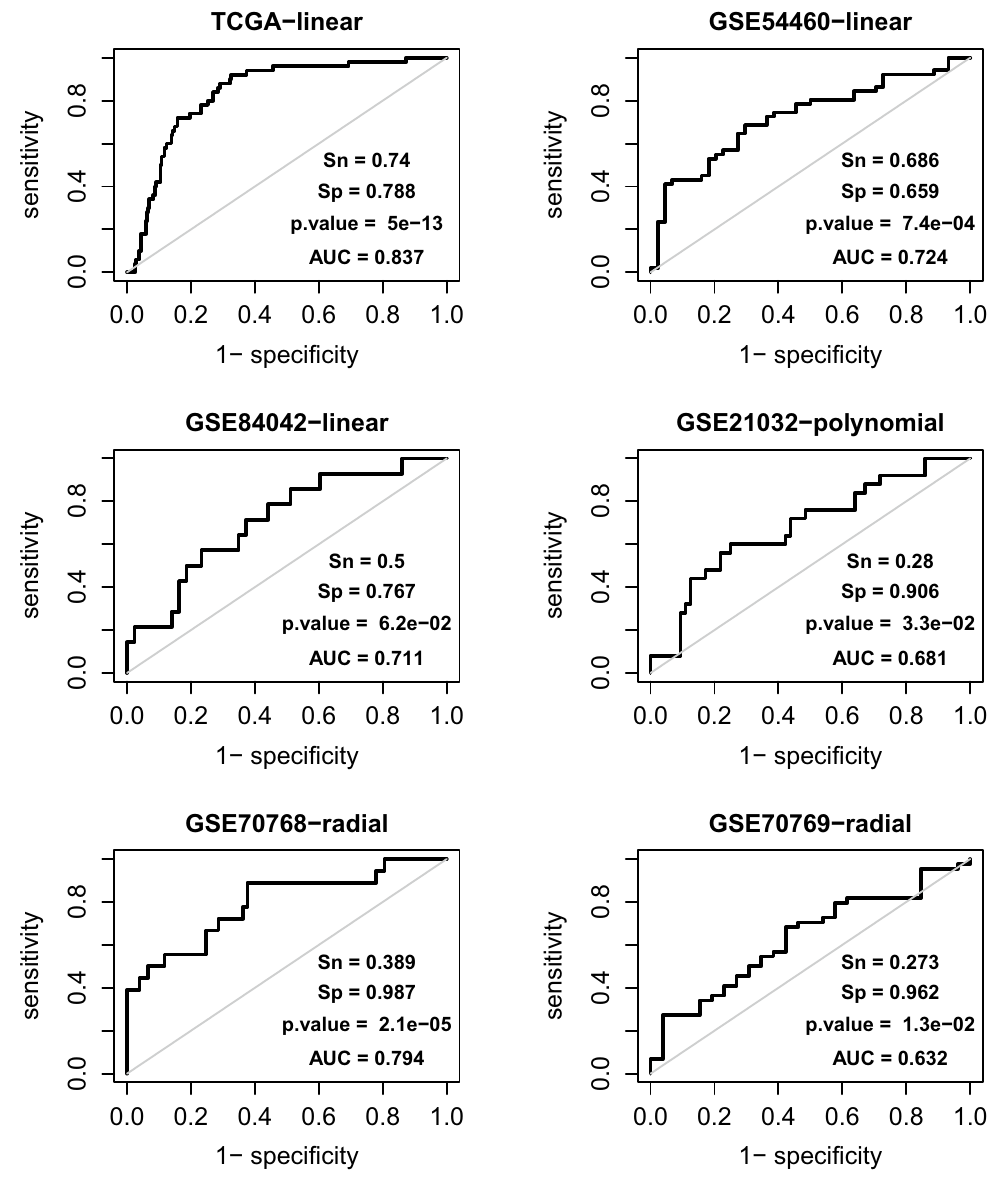
Figure 2. The performance of the TP53 mutation status-associated transcriptomic signature for BCR prediction in the discovery dataset TCGA (-PRAD) and five external datasets, i.e., the GSE54460 and others. The “-linear”, “-polynomial” and “-radial” indicate the kernel functions used in the SVM models. The output BCR label and decision value, i.e. the transcriptomic risk score (TRS) of a patient in GSE70769 was predicted by the model trained using the GSE70768 dataset. For the patients in other cohorts, the labels and scores were predicted via LOOCV. Together with the actual BCR labels, the output BCR labels and TRSs are used to calculate a 2 × 2 contingency table for estimating the p-value and to generate the ROC curve, respectively. Sn and Sp denote sensitivity and specificity,